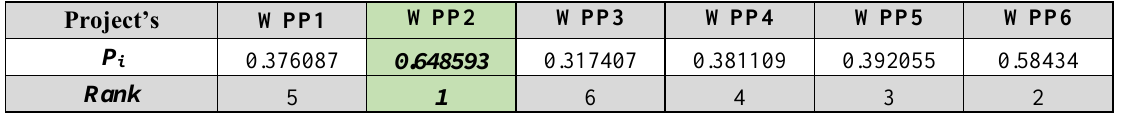
Table 13. Performance Score using TOPSIS with